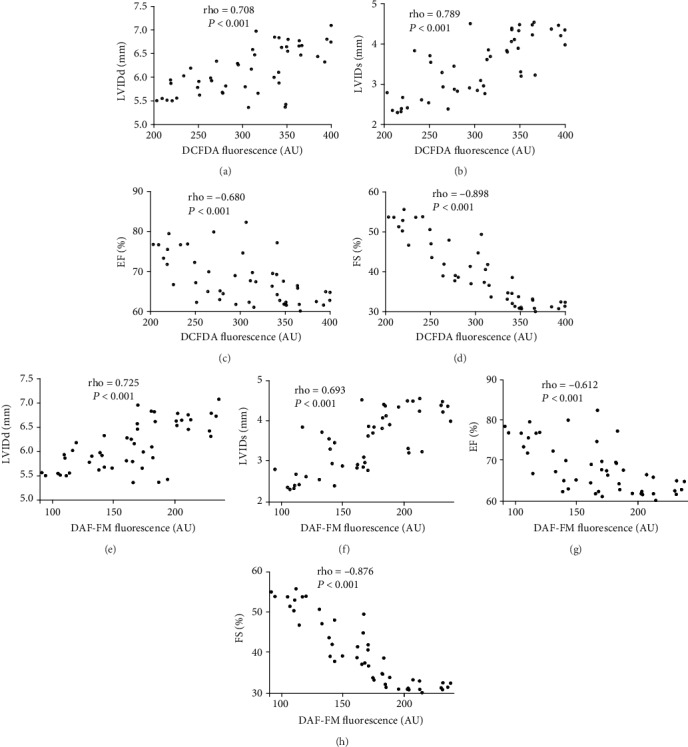
The relationship between ROS factors and cardiac function. (a) The relationship between ROS levels and LVIDd. (b) The relationship between ROS levels and LVIDs. (c) The relationship between ROS levels and EF. (d) The relationship between ROS levels and FS. (e) The relationship between RNS levels and LVIDd. (f) The relationship between RNS levels and LVIDs. (g) The relationship between RNS levels and EF. (h) The relationship between RNS levels and FS.